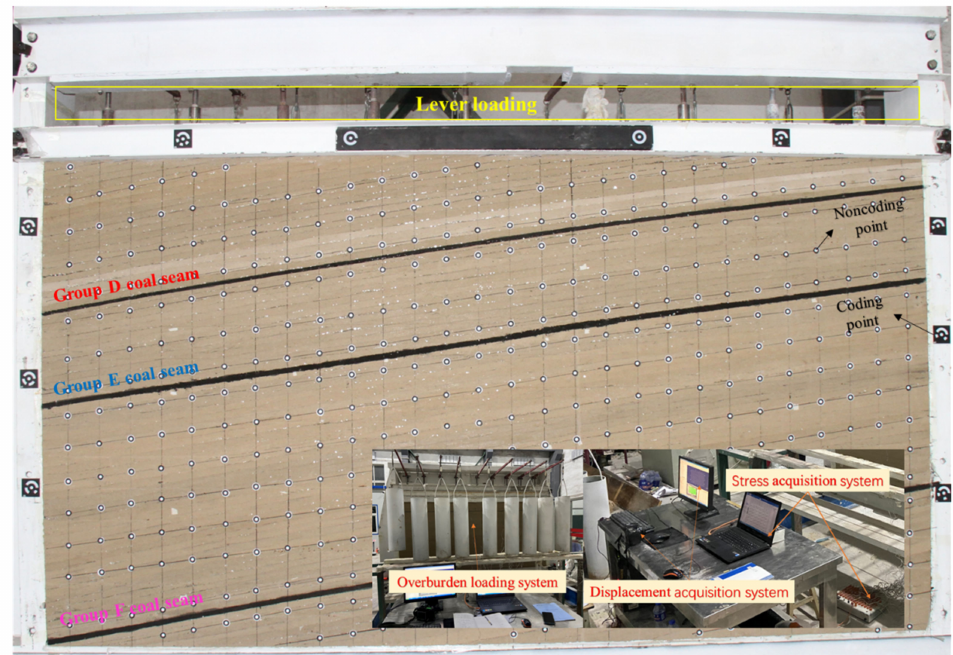
Figure 3. Similar material